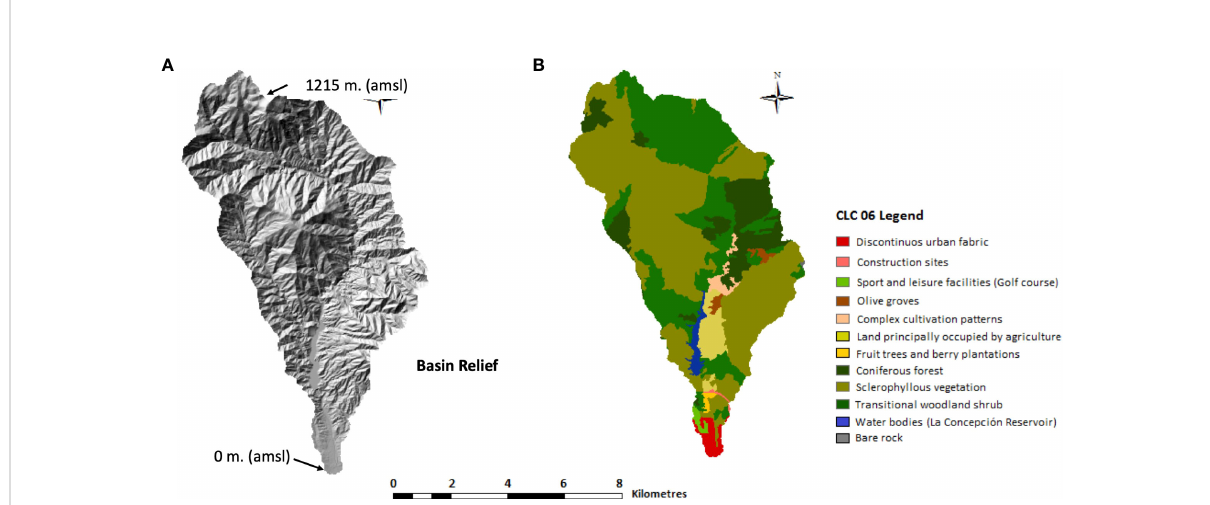
FIGURE 3 Topography and land cover classes of the river Verde basin. (A) Topography has been calculated by using the digital elevation model (DEM) at a 25-m spatial resolution taken from the National Geographic Survey of Spain; (B) land cover classes have been represented according to the of fi cial Corine Land Cover dataset collected in